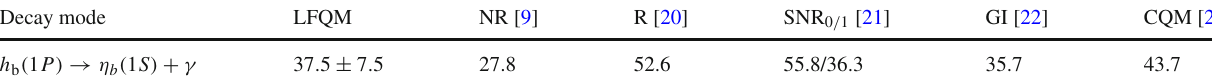
Table 2 Decay width (in units of keV) of h b ( 1 P ) → η b ( 1 S ) + γ in the light-front quark model, denoted LFQM, as compared with predic- tions from other theoretical models, including non-relativistic potential model (NR) [9], relativistic quark model (R) [20], the Godfrey–Isgur